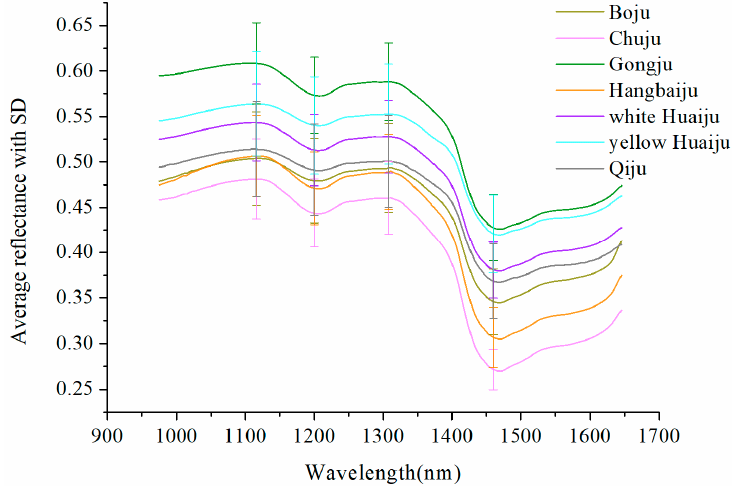
Figure 1. The average spectra of Chrysanthemum samples of seven varieties.